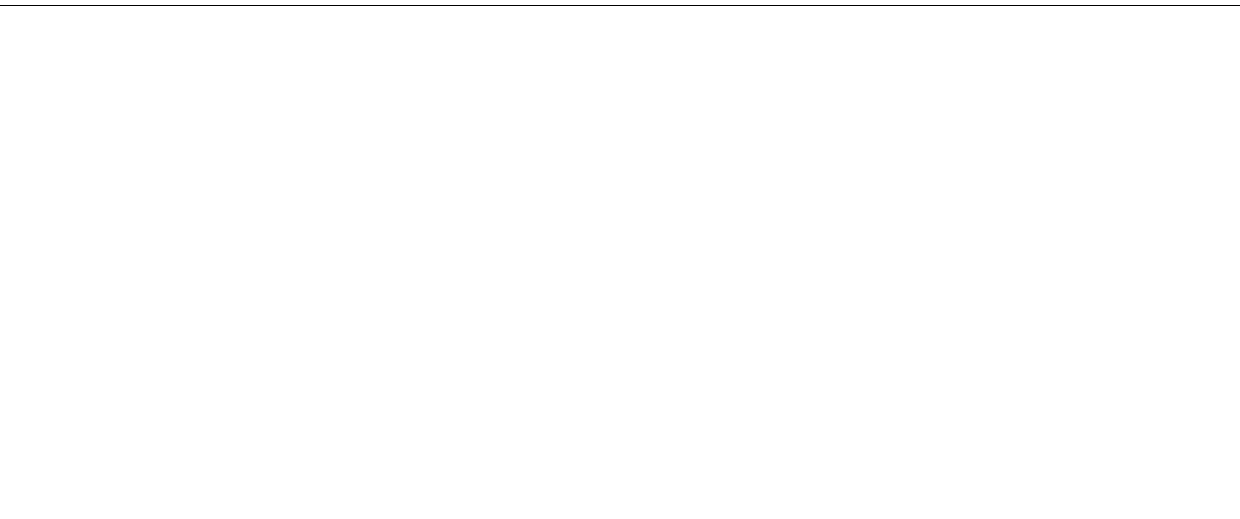
Frontiers in Pharmacology |